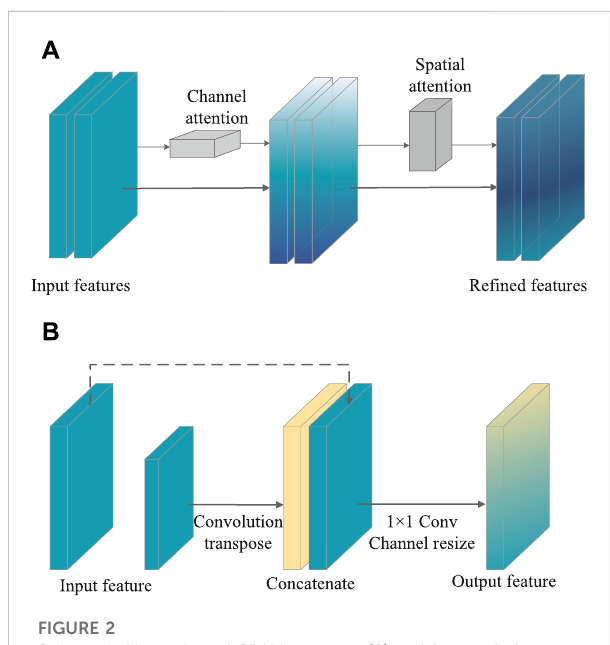
FIGURE 2 Schematic illustration of CBAM structure (A) and feature fusion module (B)